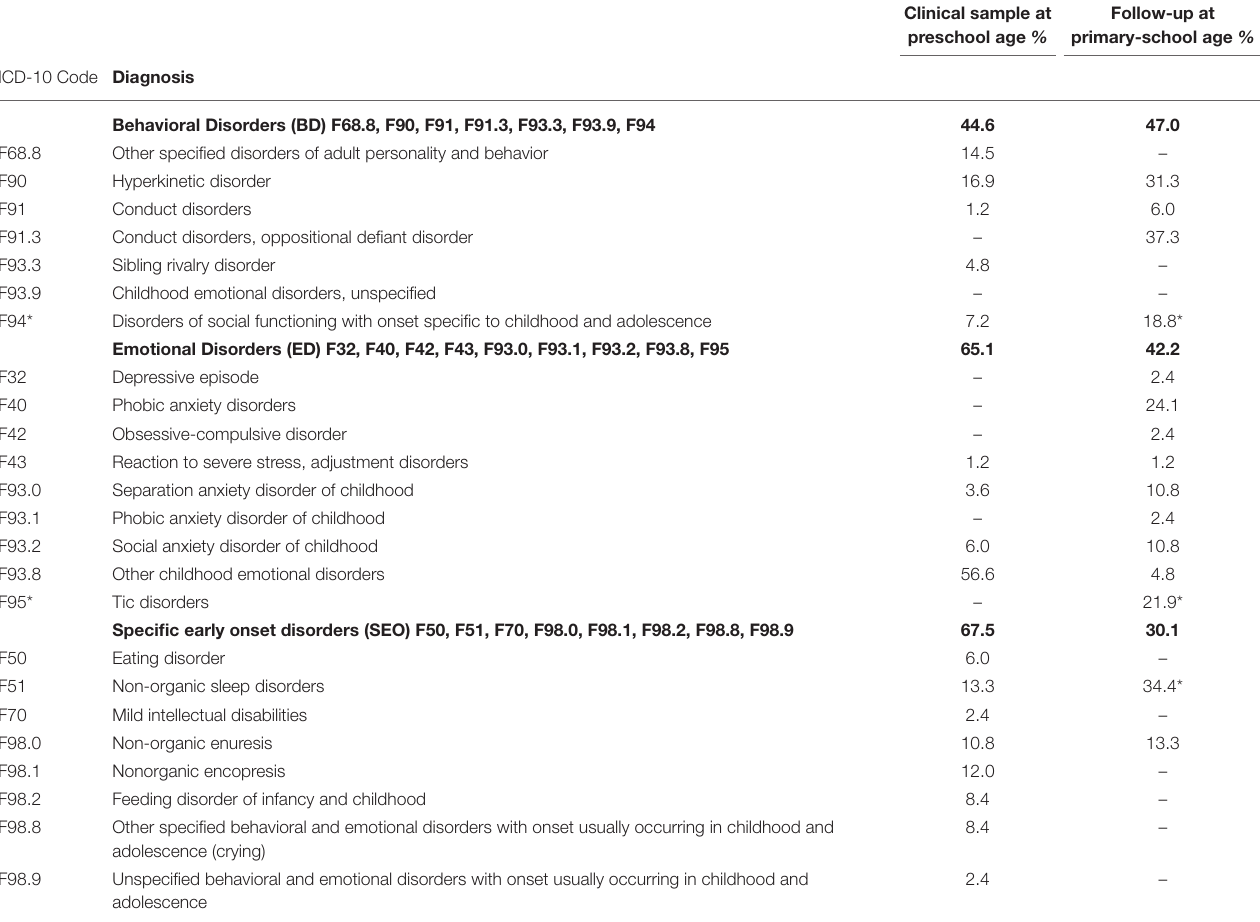
TABLE 1 | Frequencies of single disorders and emotional disorders cluster (ED), behavioral disorders (BD), and specific early onset disorders cluster (SEO) at preschool age and primary-school age ( N = 83) in percentages of ICD-10 diagnoses; multiple disorders for each preschool child were possible.